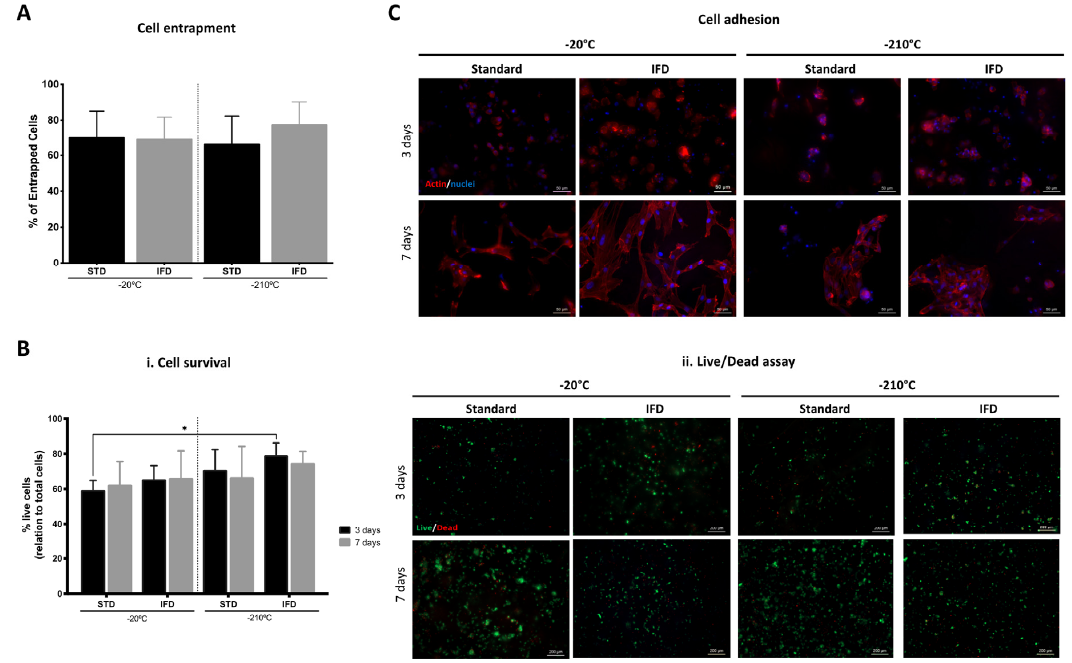
Figure 5. Effect of freezing conditions (standard method (STD), NFD, and IFD at − 20 and − 210 °C) over human dermal fibroblasts’ (hDFbs) behavior in 1.25% GG spongy-like hydrogels. ( A ) Representation of the entrapment efficiency 24 h after cell seeding. ( B ) (i) Representation of the percentage of the live cells three and seven days of culture. (ii) Representative fluorescence microscopy images showing the dead (red) and the live (green) cells, respectively stained with propidium iodide (PI) and calcein-AM (Ca-AM) after three and seven days of culture. Scale bar = 200 μ m. ( C ) Representative fluorescence microscopy images of hDFbs after three and seven days of culture showing the F-actin cytoskeleton (phalloidin-TRITC, red) and nuclei (DAPI, blue). Scale bar = 50 µ m. Data were obtained from three independent experiments with three replicates for each condition, * p < 0.05, two-way ANOVA and Bonferroni’s post-hoc